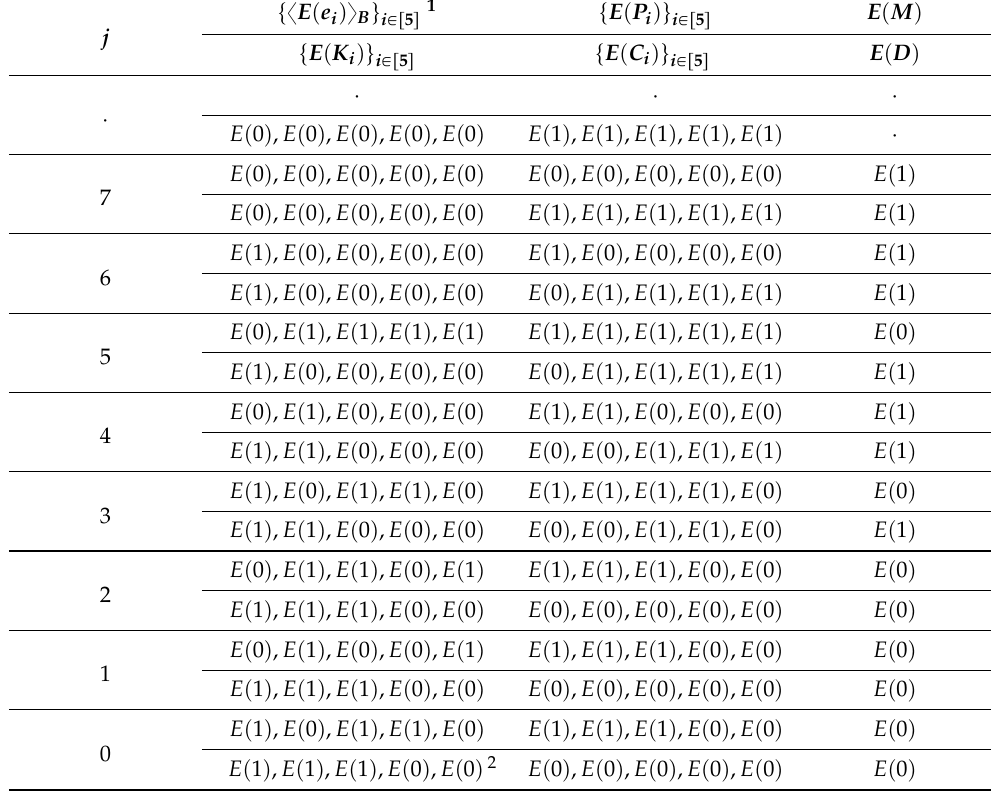
Table 3. Example of Algorithm 2 for S k LE S